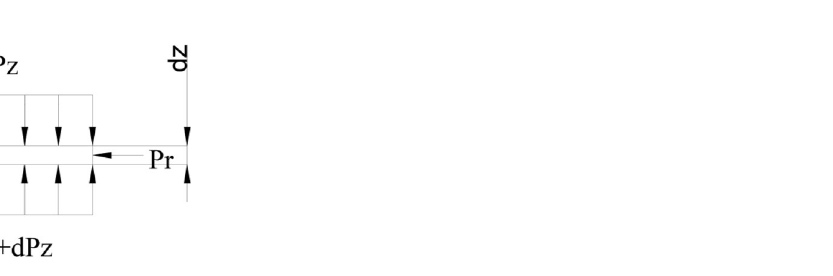
Figure 3. Approximate average pressure of material in